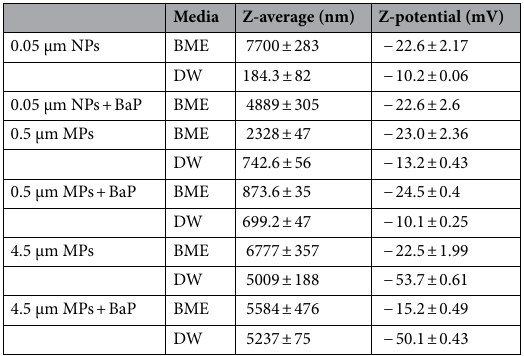
Table 1. Hydrodynamic size (Z-average) and surface charge (Z-potential) of NPs and MPs alone or in combination with BaP suspended in supplemented Basal Medium Eagle (BME) and in distilled water (DW). Data are given as mean ± SD values (n =